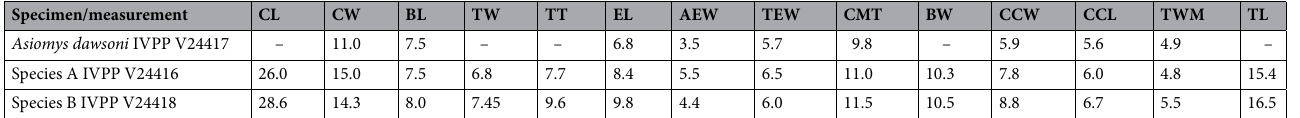
Table 1. Measurements (in mm) of ischyromyid calcanei from the early middle Eocene of the Erlian Basin, Nei Mongol, China. For measurements and abbreviation definitions, see Fig.